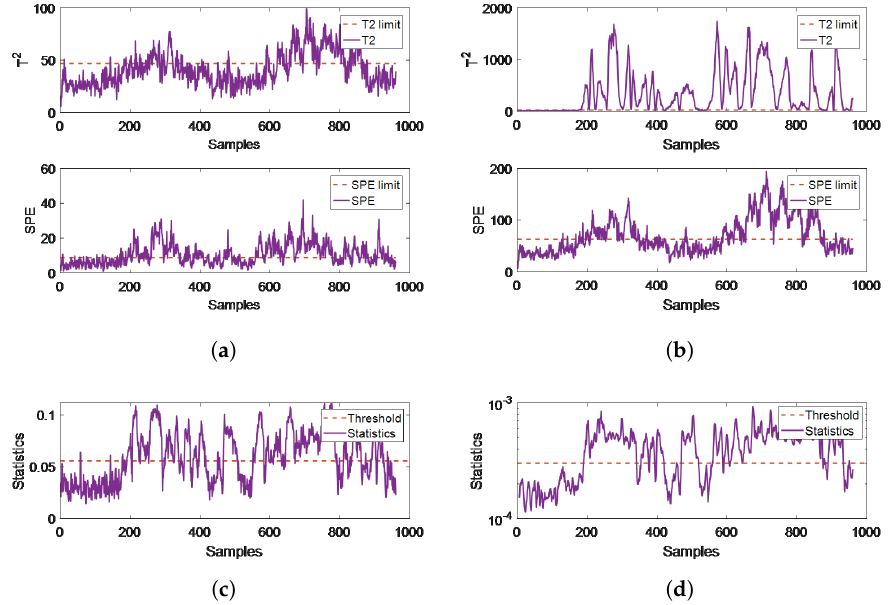
Figure 6. Comparison of detection results for Fault10: ( a ) Fault detection by PCA; ( b ) Fault detection by GLPP; ( c ) Fault detection by SAE; ( d ) Fault detection by